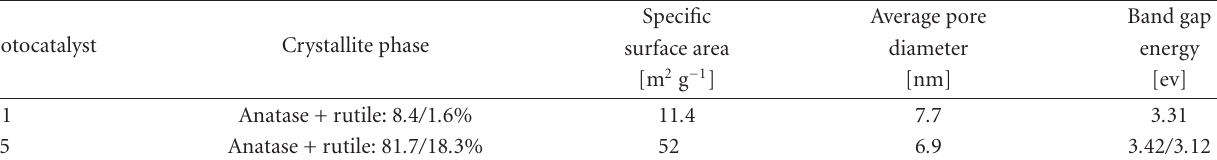
Table 1: The basic properties of Tytanpol A11 and Degussa P25 photocatalysts.